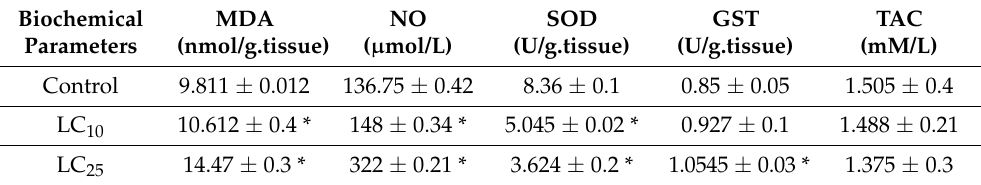
Table 4. Effects of SeNP exposure on some biochemical parameters of B. alexandrina snails. Biochemical Parameters